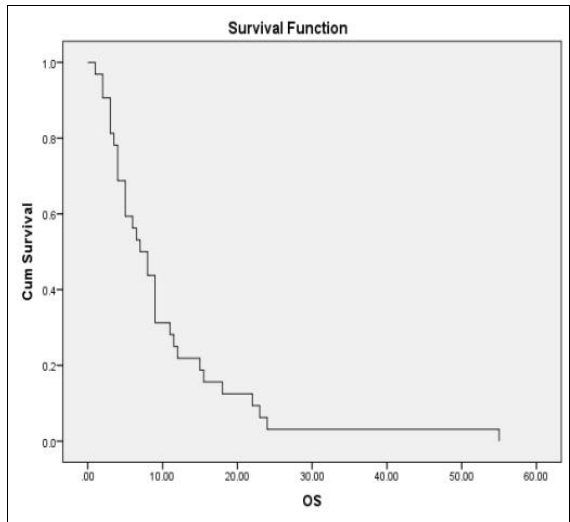
Figure 2: Overall survival curve of 32 patients with brain